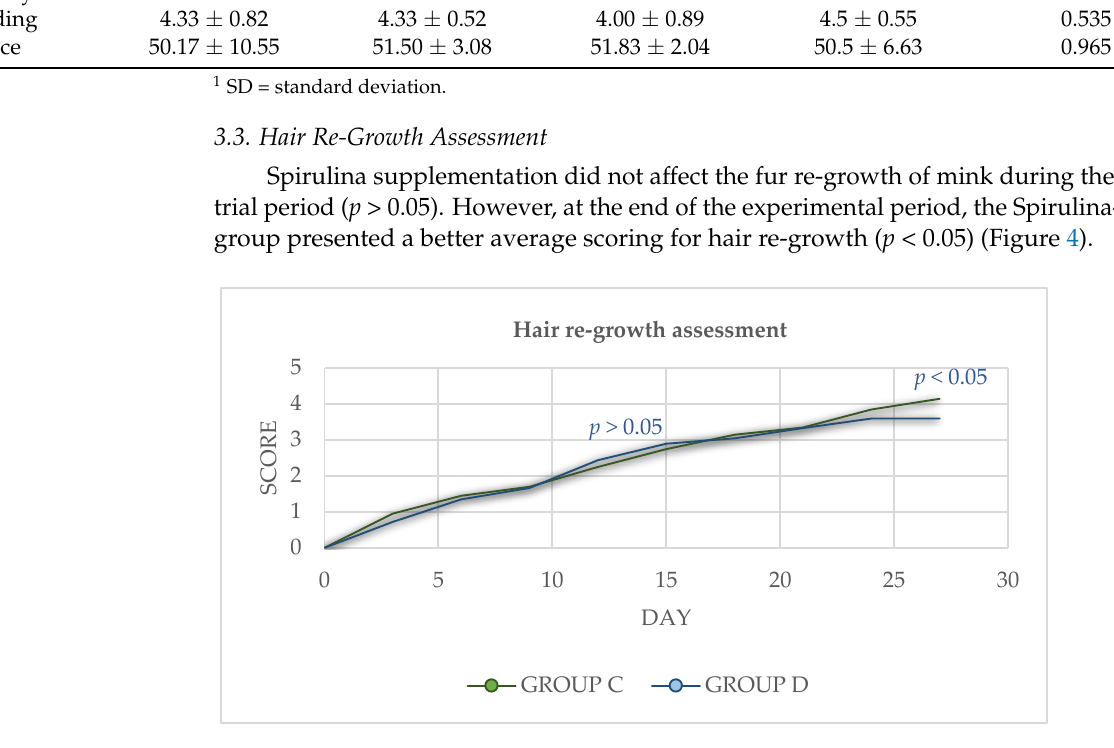
Figure 4. Hair re-growth assessment for the overall experimental period (27 days).